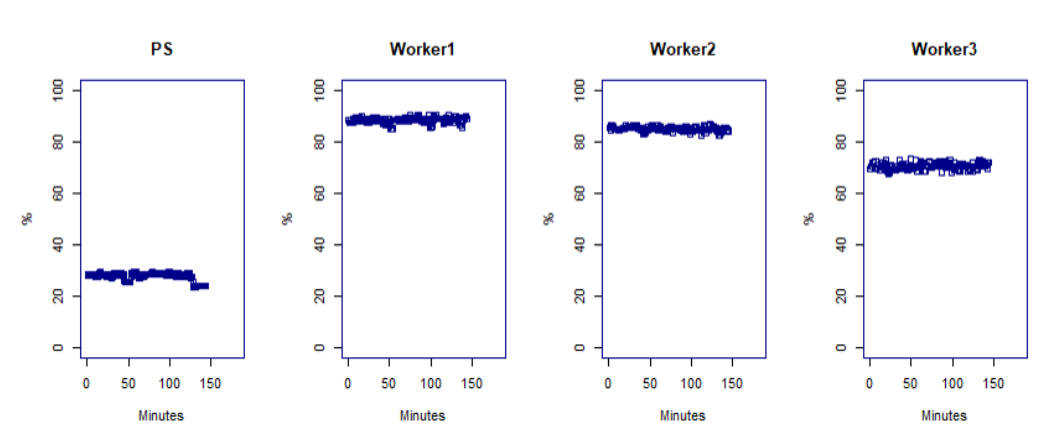
Figure 16. CPU load per worker for the data parallelism scheme.